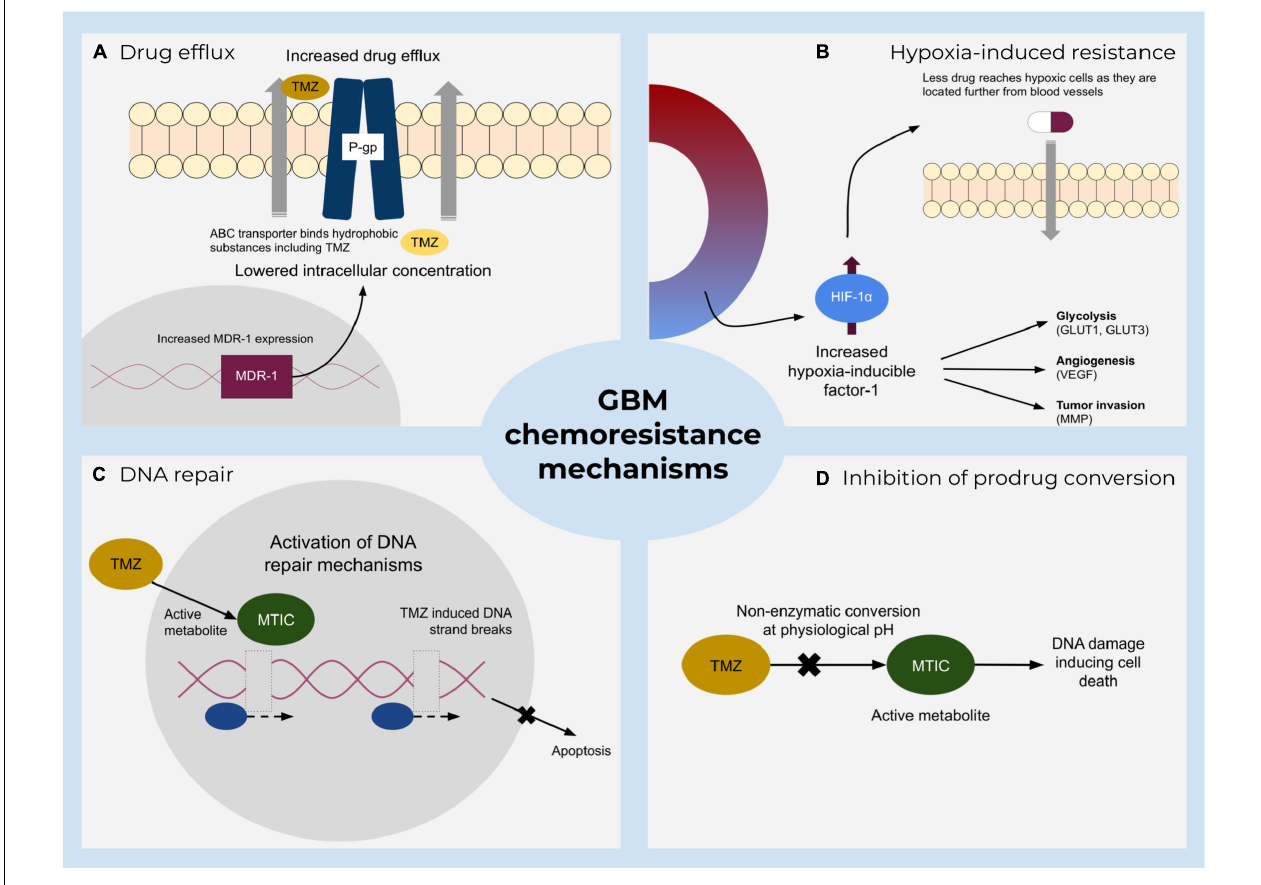
FIGURE 1 | A summary of major resistance mechanisms to standard treatment of glioblastoma. Main impeding factors include (A) increased active TMZ efflux by ATP-binding cassette transporters that lower the drug concentration and hence its effect. (B) Hypoxia-mediated chemoresistance caused by various hypoxia-inducible factor-1 (HIF-1) activities. (C) Direct and indirect DNA damage repair mechanisms and (D) inhibition of prodrug conversion which prevents DNA